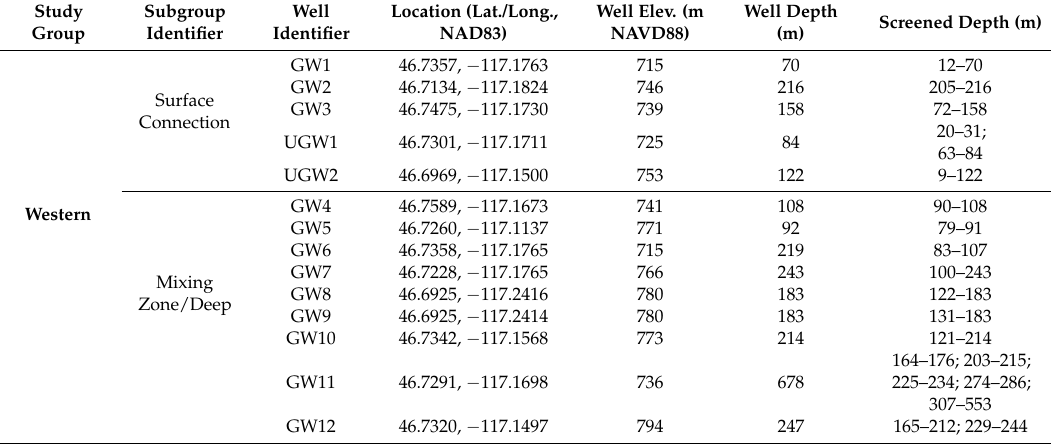
Table 2. Descriptions of wells in and near Pullman (Western), Washington, sampled as part of this study (Figure 1). Subgroup identifiers relate to likely source waters and depth. Well identifiers are based on formation and depth of screen interval(s) as determined from the geologic layer model (G = Grande Ronde, UG = Upper Grande Ronde) and location (W =